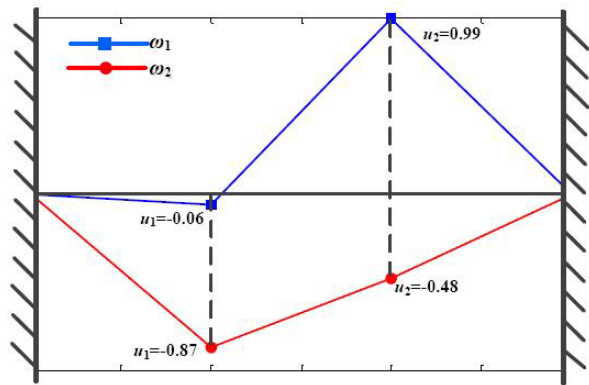
Figure 2. Modal shapes of each natural